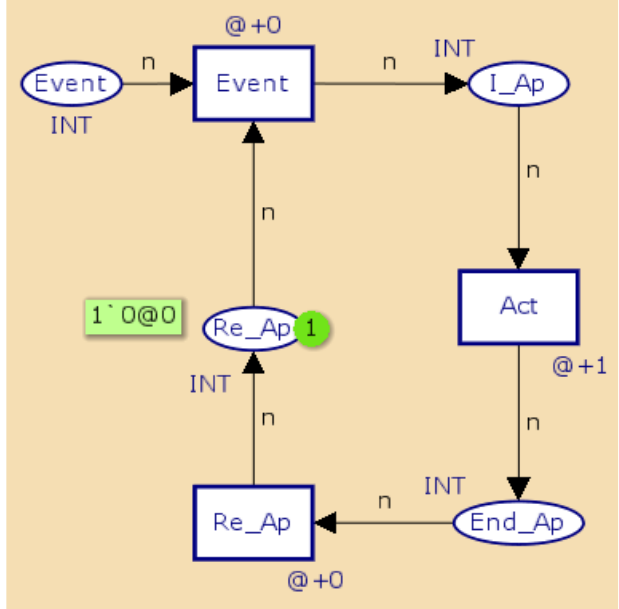
Figure 4. Representation in CPN of an aperiodic